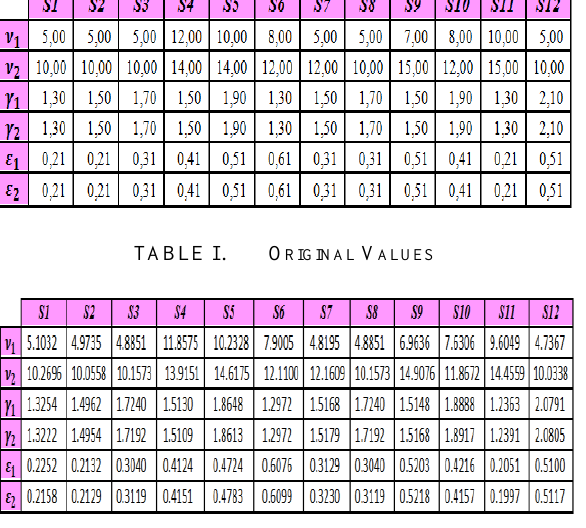
Retrieval Values (without impact of vegetation)